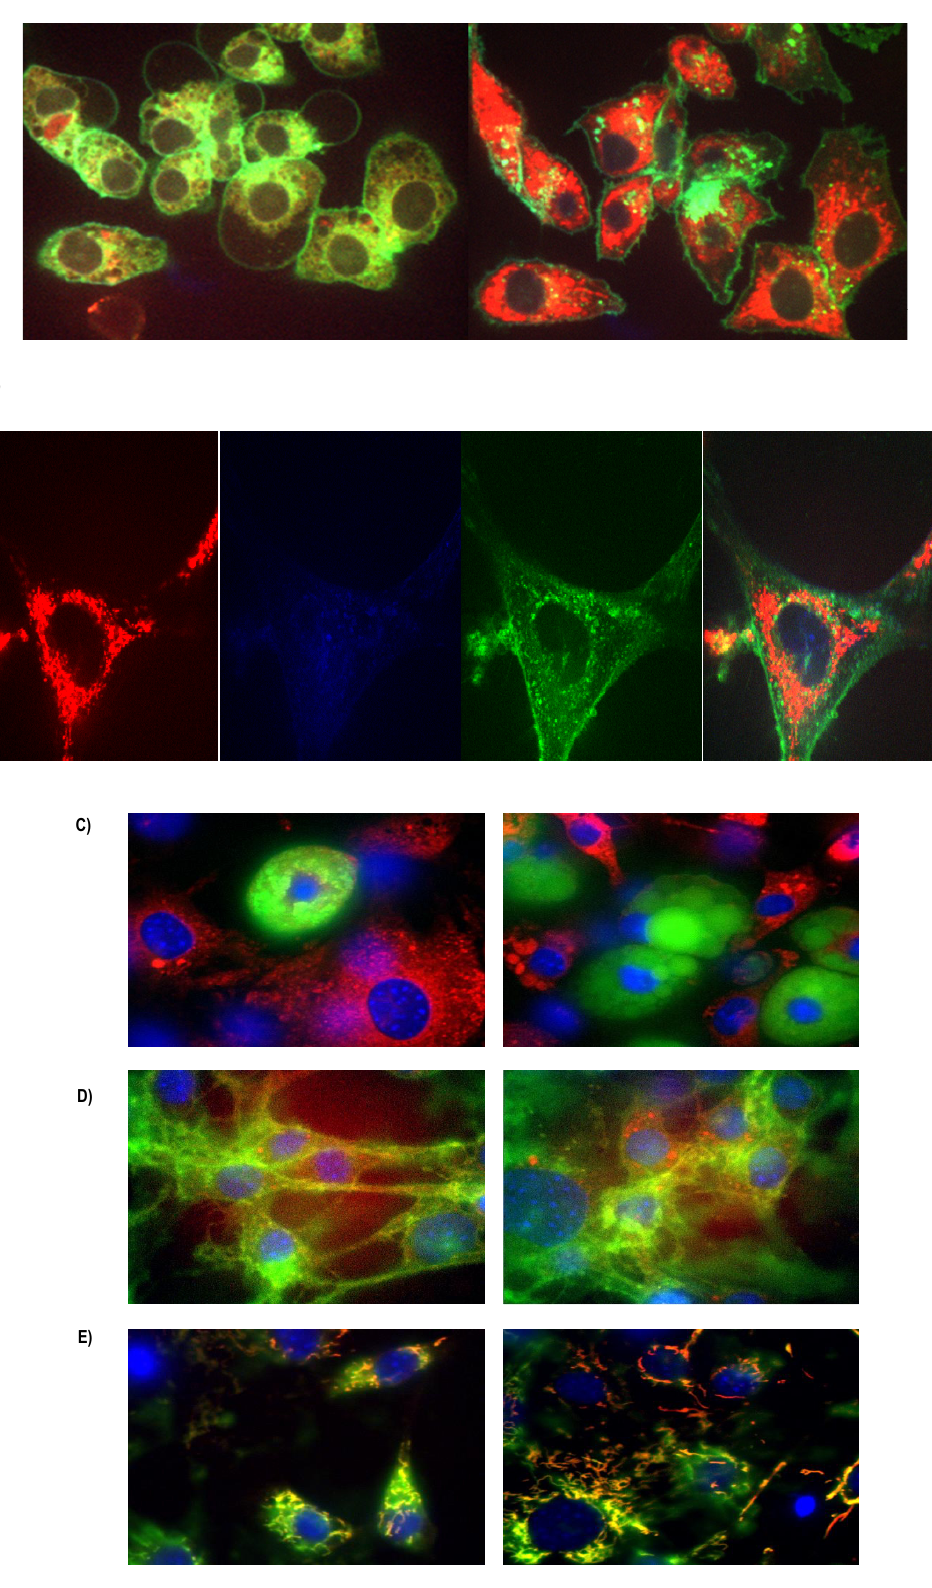
Figure 2. Fluorescent labeling of internalized T1AM in di ff erentiated 3T3-L1 cells. ( A ) Internalization of T1AM is extremely rapid, with FL-T1AM being detected inside cells within seconds of addition